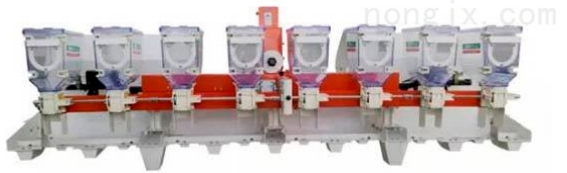
Figure 1. Datong 2BD-8A (DXD830) rice direct seeding machine.